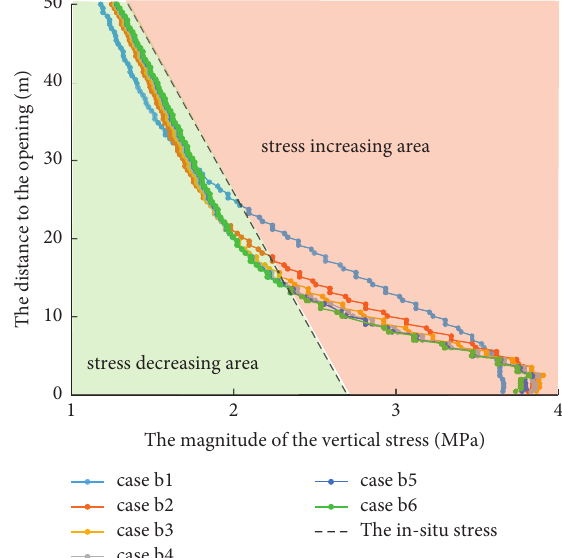
Figure 6: The relationship between the vertical stress and the distance to the